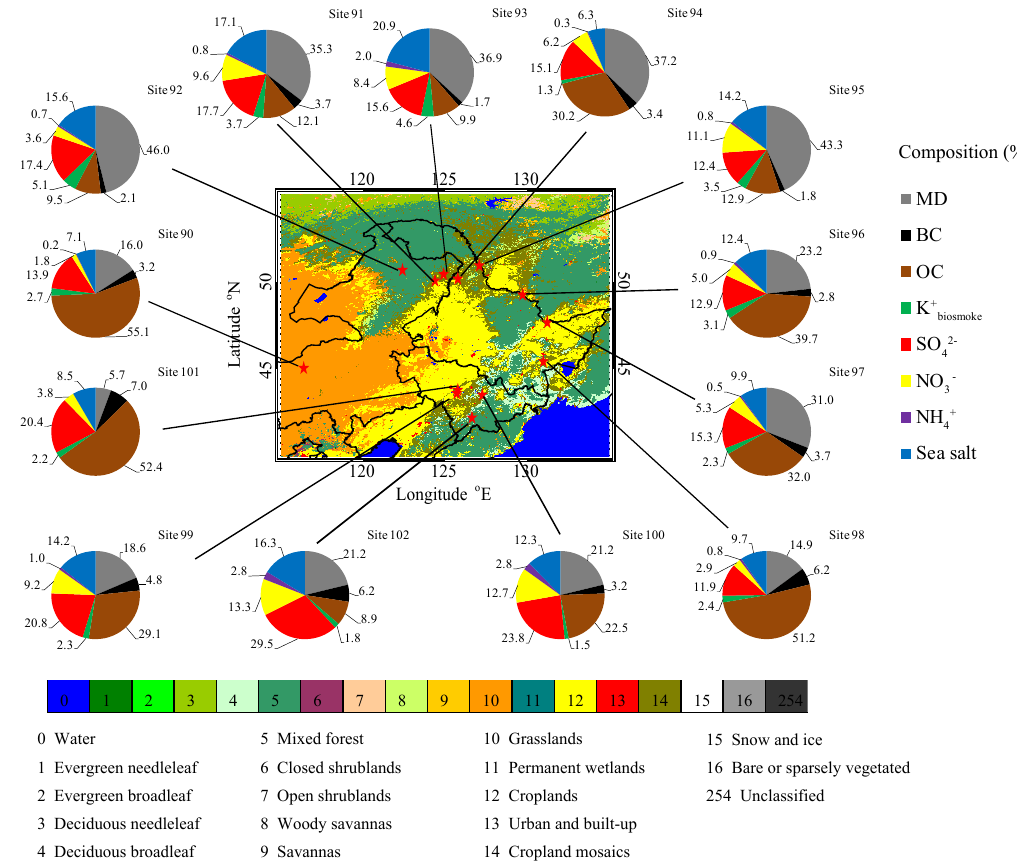
) , and sea salt in the surface , secondary ions (SO 2 − , NO − , and NH + Biosmoke 4 3 4 , NO − , and NH + were reprinted from 4 3 4